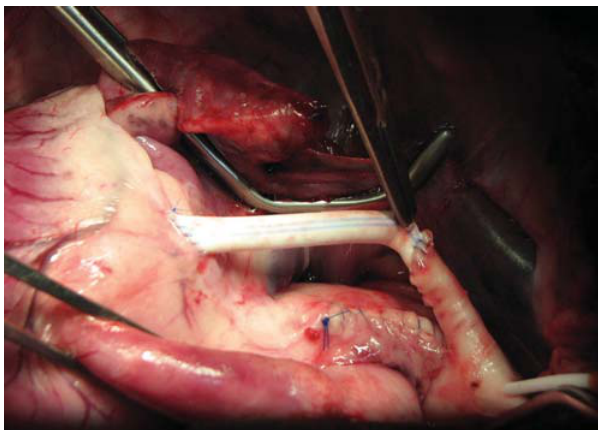
Figure 3 - PTFE tube implanted in the distal end of the aortic graft (simu- lating a saphenous graft) resulting in a composite graft with a homogenous